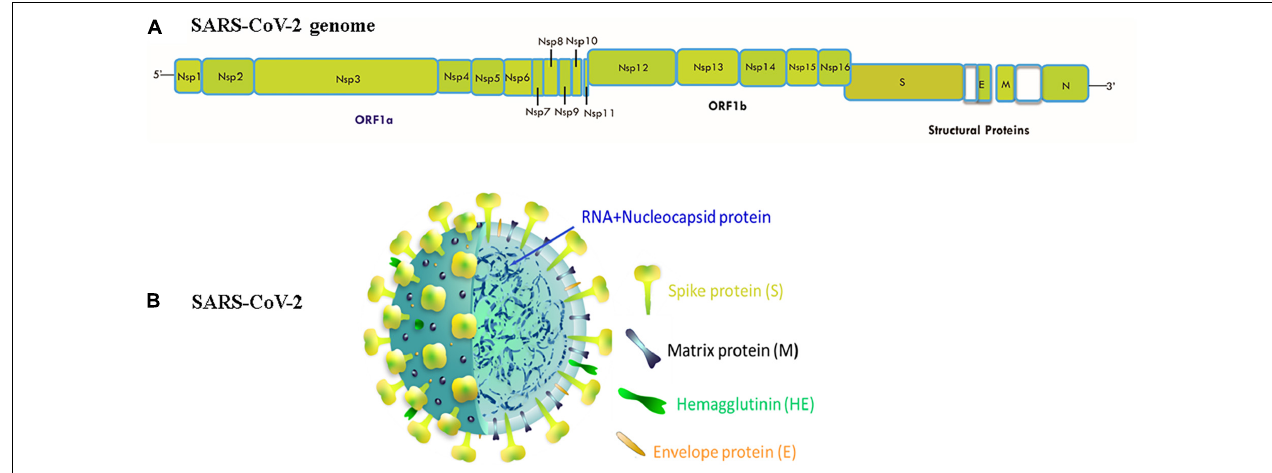
FIGURE 1 | (A) Genomic organization of SARS-CoV-2: 5 (cid:48) and 3 (cid:48) terminal sequences of the genome of SARS-CoV-2. 5 (cid:48) -replicase ORF1ab-spike (S)-envelope (E)-matrix (M)-nucleocapsid (N)-3 (cid:48) is the gene order. At the expected position shown in the figure, Nsp1, Nsp2, Nsp3, Nsp4, Nsp5, Nsp6, Nsp7, Nsp8, Nsp9, Nsp10, Nsp11, Nsp12, Nsp13, Nsp14, Nsp15, Nsp16, S, E, M, N serve as various ORF genes in the frame. (B) Structure of SARS CoV-2:The genomic size of β -coronavirus ranges from 29 to 32 Kb. The virion has a genomic RNA and phosphorylated nucleocapsid (N) protein with a nucleocapsid that is concealed within phospholipid bilayers and coated with the spike glycoprotein trimmer (S). In the envelope of the virus, the matrix (M) protein hemagglutinin-esterase (HE) and envelope (E) protein are placed amid S proteins.